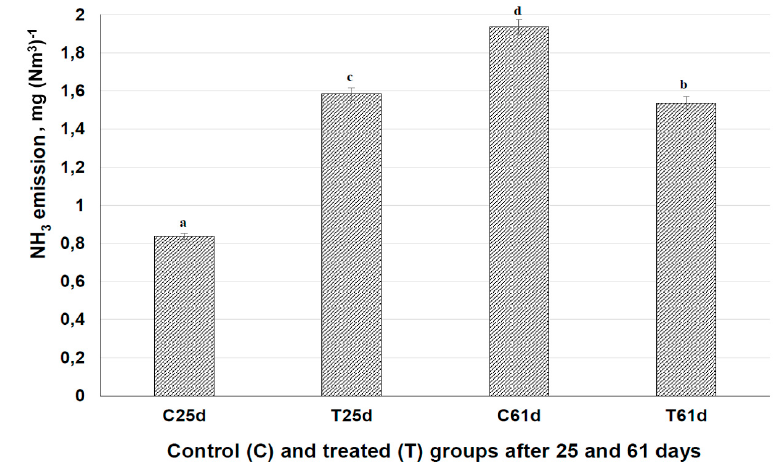
Figure 6. Ammonia (NH3) emission in farm sections with piglets fed non-fermented and fermented feeds. The data are expressed as the mean ± standard deviation ( n = 3). The data were statistically compared with a paired t-test and column statistics. Means followed by different letters (a,b,c,d) are significantly different ( p ≤ 0.05).